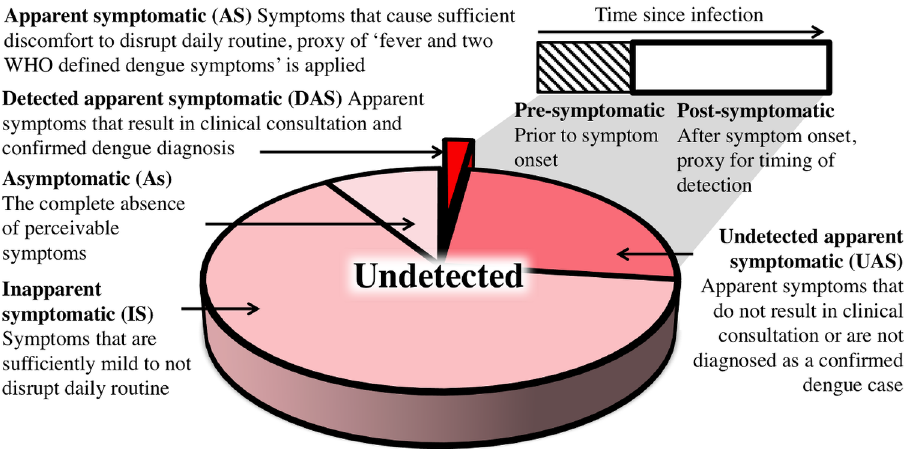
Fig 2. Definitions of DENV infection